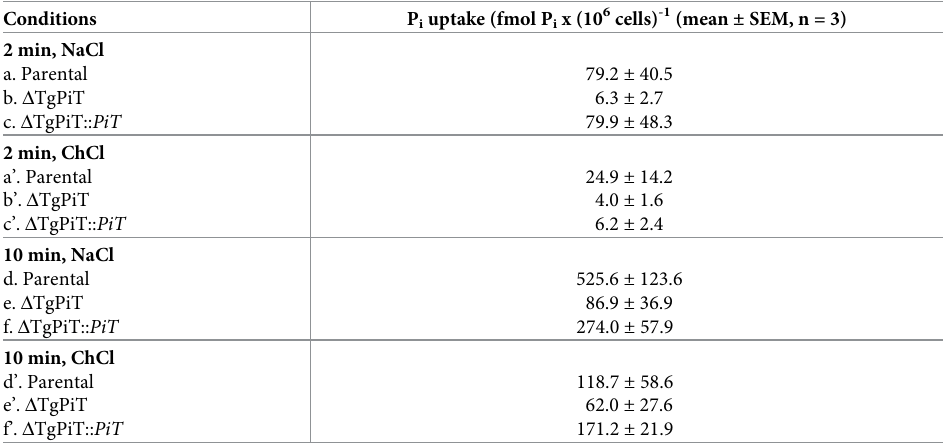
Table 1. P i uptake by parental, Δ TgPiT and Δ TgPiT:: PiT parasites Intracellular parasites were cultivated for 24 h in P i -depleted DMEM with 1% FBS prior to the phosphate uptake assay, which was performed as described in leg- end of Fig 1, in a P i -depleted reaction medium at pH 7.4 containing 100 μ M 32 P i in the presence of 140 mM NaCl or choline chloride (ChCl) for energized and unenergized phosphate uptake conditions, respectively, at the indi- cated times.